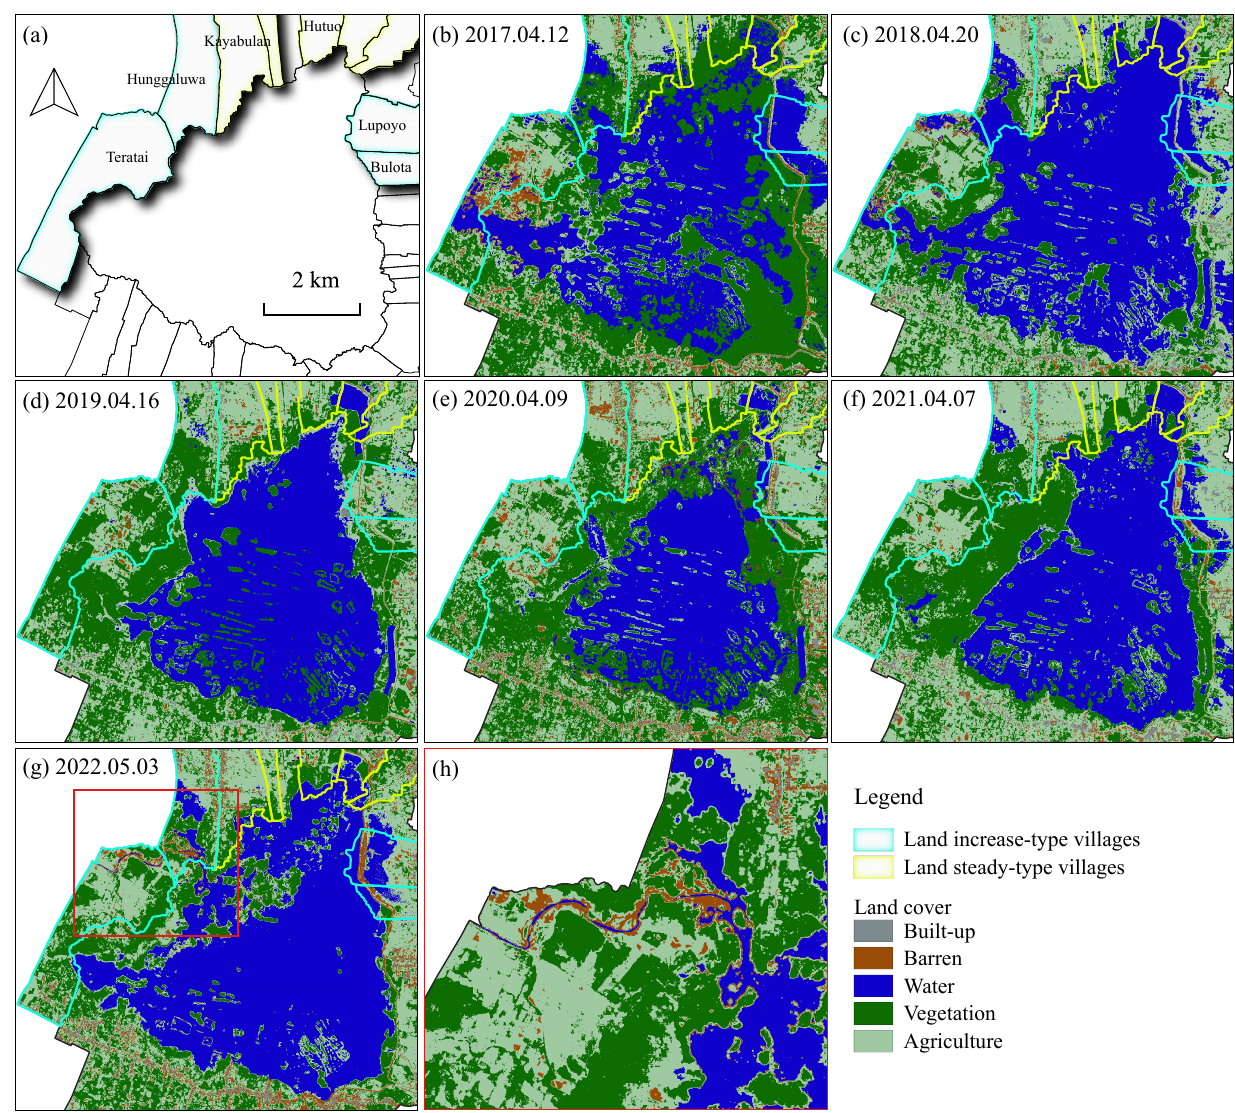
Figure 5. Example of LCTs at the lake surrounding areas using PS series: ( a ) lake-side overview; ( b – g ) LCTs (2017 − 2022); ( h ) overview of ( g ) 2022 (cid:48) s red